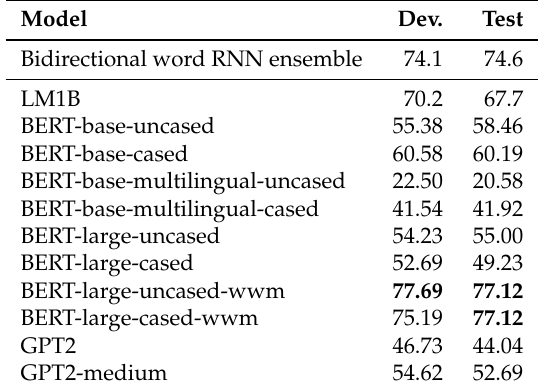
Table 3. Accuracy results (%) of pre-trained models without fine-tuning for the MSR questions. The best model trained with the official dataset is presented at the first row for comparison. Model